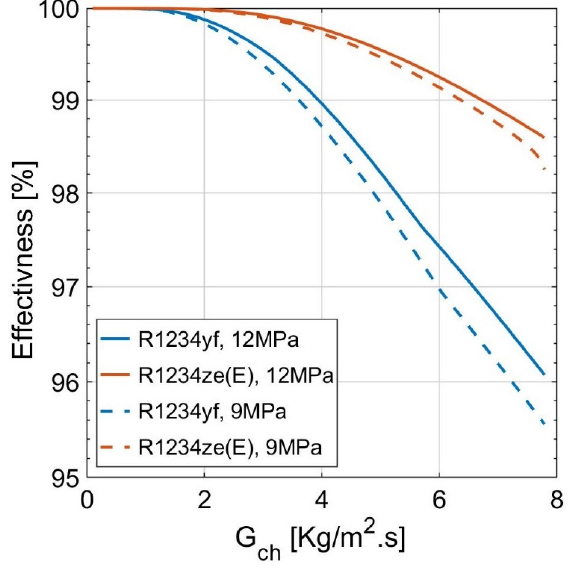
Figure 11. Effectiveness at various cold channel mass fluxes and hot stream inlet pressures.